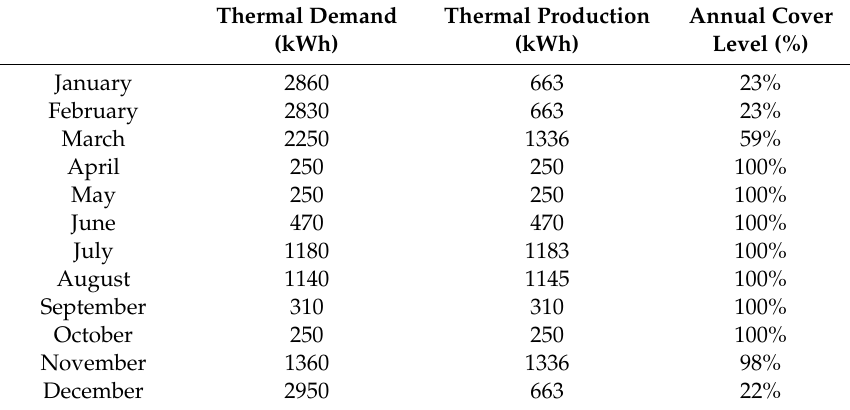
Table 4. Cover level of the thermal